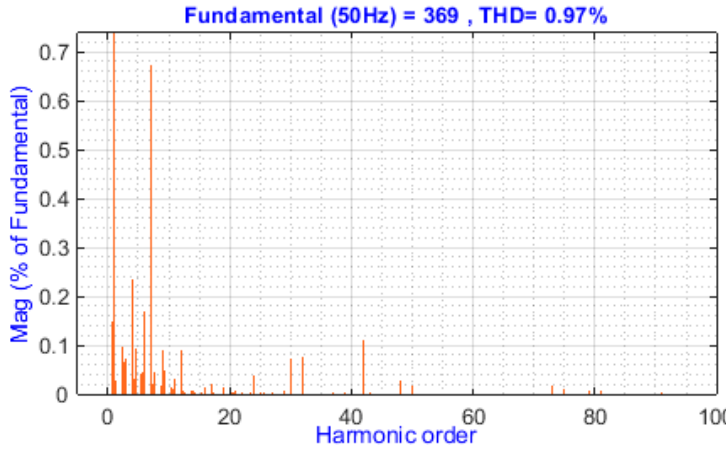
Figure 16. Total and individual harmonics level of the output current at PCC after filtering.